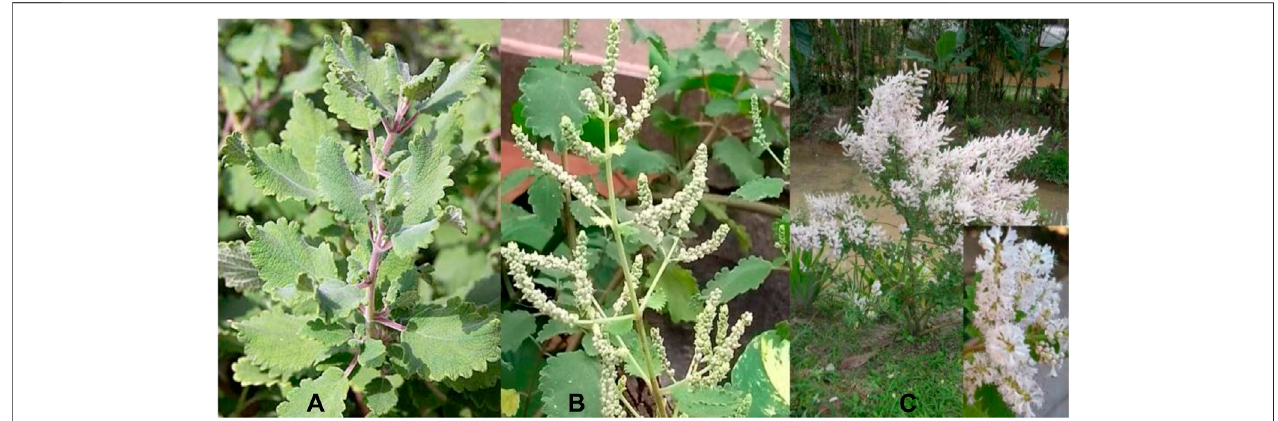
FIGURE 1 | T. riparia culture planted in the medicinal garden of Paranaense University. Umuarama, Parana, Brazil. (A) : leaves (B) : Flower buds (C) Open fl owers. Source: the authors.